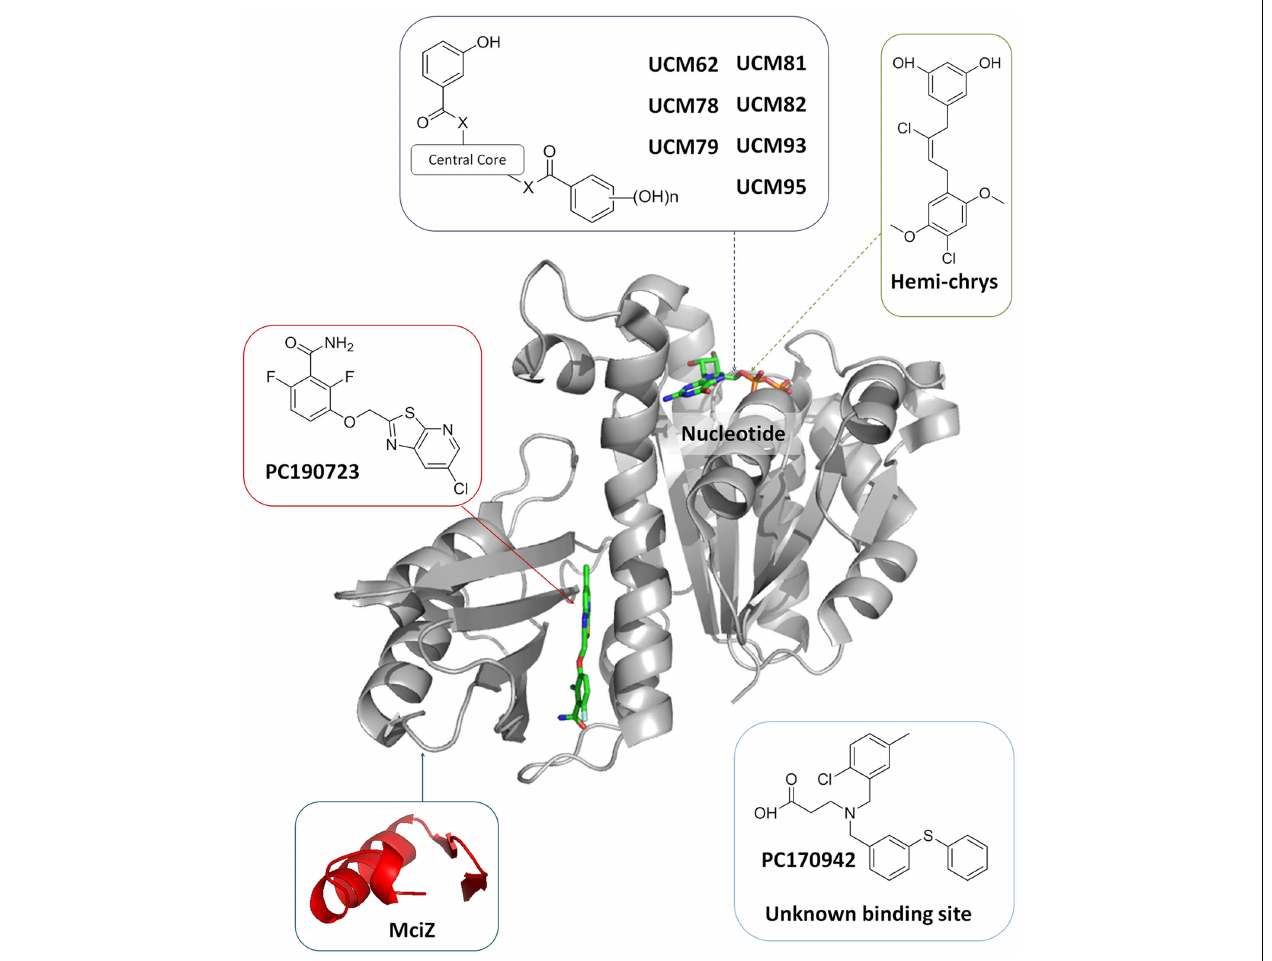
FIGURE 1 | FtsZ inhibitors used in the cytological profile analysis. Schematic representation of inhibitors binding sites on FtsZ from Bacillus subtilis (based on Protein Data Bank entries 4DXD and 4U39). Notice that PC190723 requires the binding cleft to open (Elsen et al., 2012) See full compound list and antibacterial activities in Supplementary Table S1. Peptide MciZ (Bisson-Filho et al., 2015) was included in this scheme after the activity of synthetic MciZ on cell division was found (See